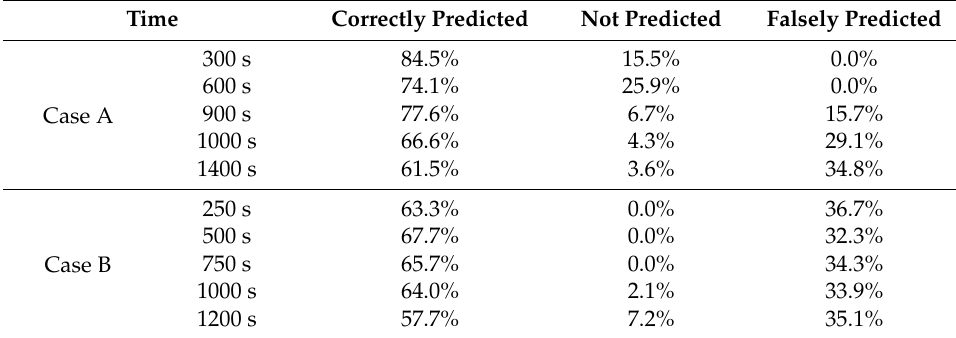
Table 5. Proportion of the road length that is correctly predicted/not predicted/falsely predicted in the two cases.